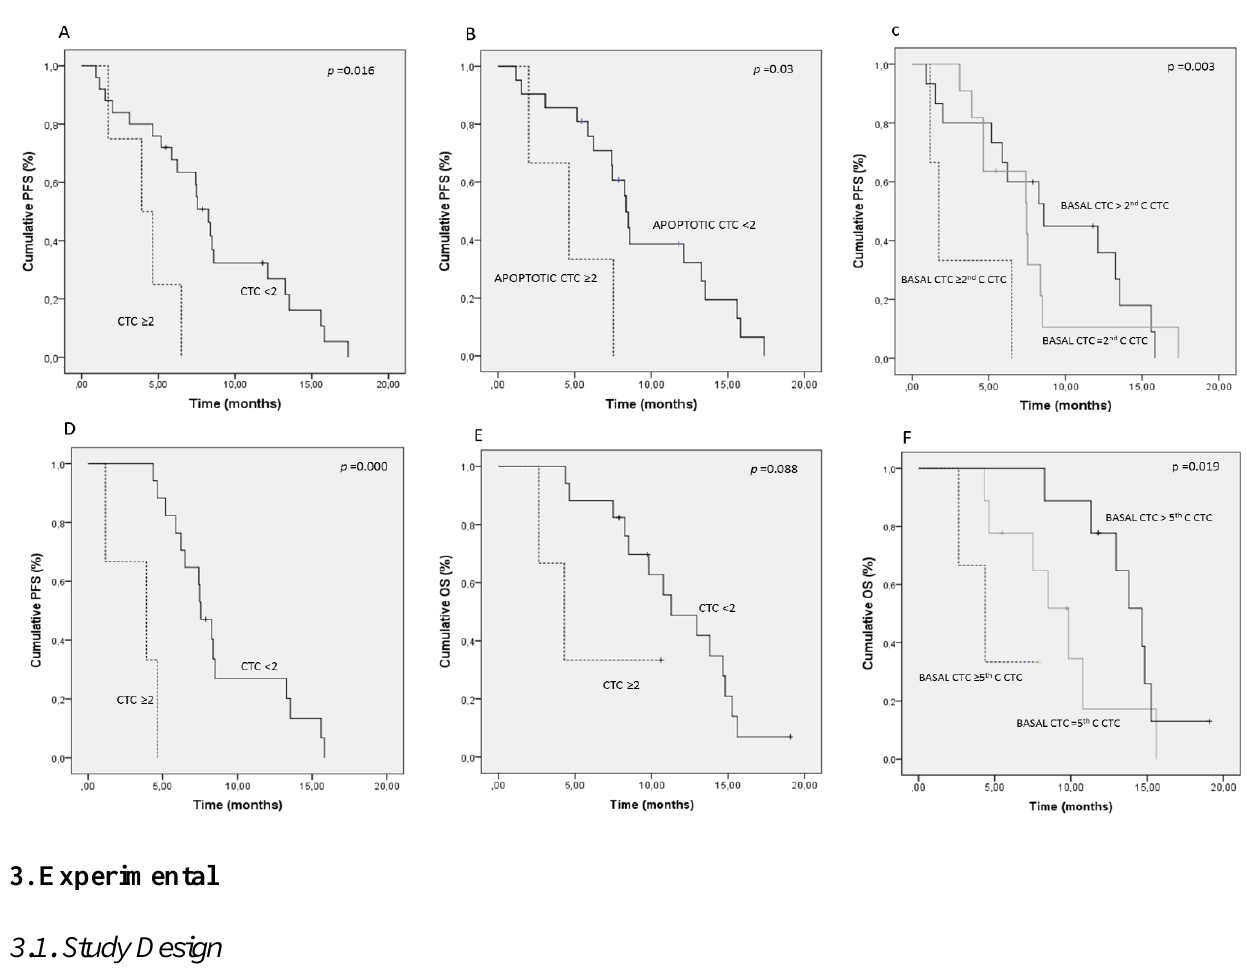
Figure 4. Kaplan-Meier curves for progression-free survival and overall survival . Only parameters with significant impact in patient outcome are represented. ( A ) Morphological intact CTC levels at 2nd cycle of chemotherapy; ( B ) CTC fragments at 2nd cycle of chemotherapy in patients with ≤2 CTC; ( C ) Changes in morphological intact CTC levels between baseline and 2nd cycle of chemotherapy; ( D , E ) Morphological intact CTC levels at 5th cycle of chemotherapy for PFS and OS, respectively; ( F ) Changes in CTC levels between baseline and the 5th cycle of